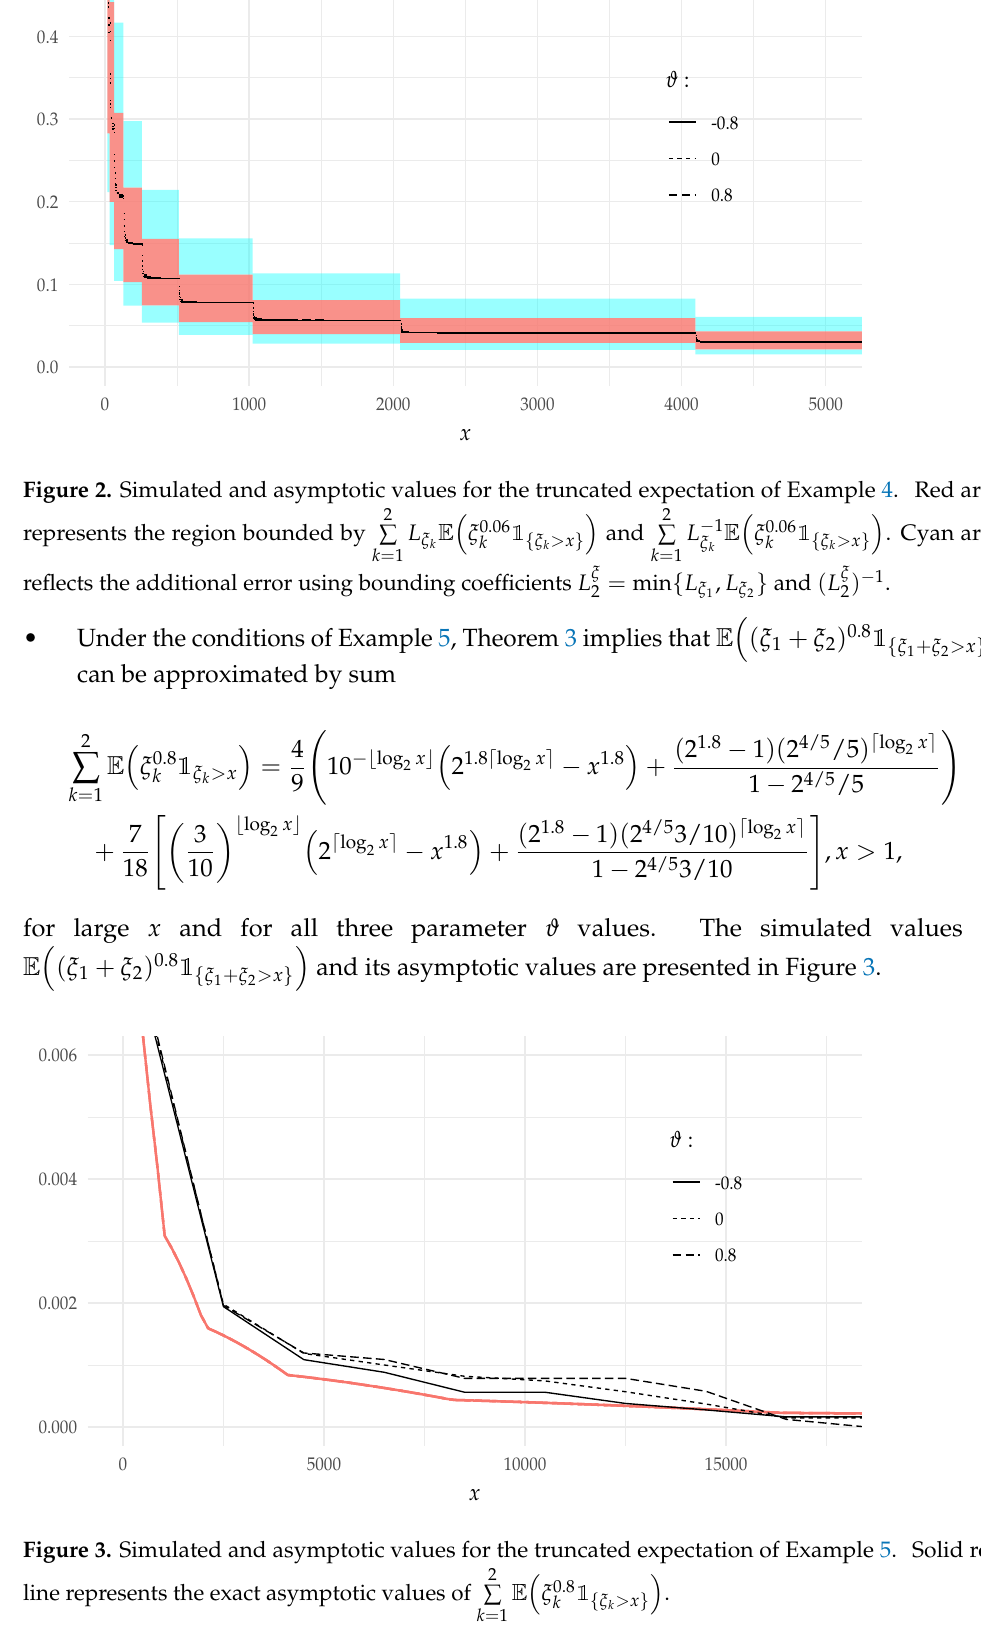
(cid:16) (cid:17) 2 E 1 ∑ ξ 0.8 { ξ k > x } k k = 1